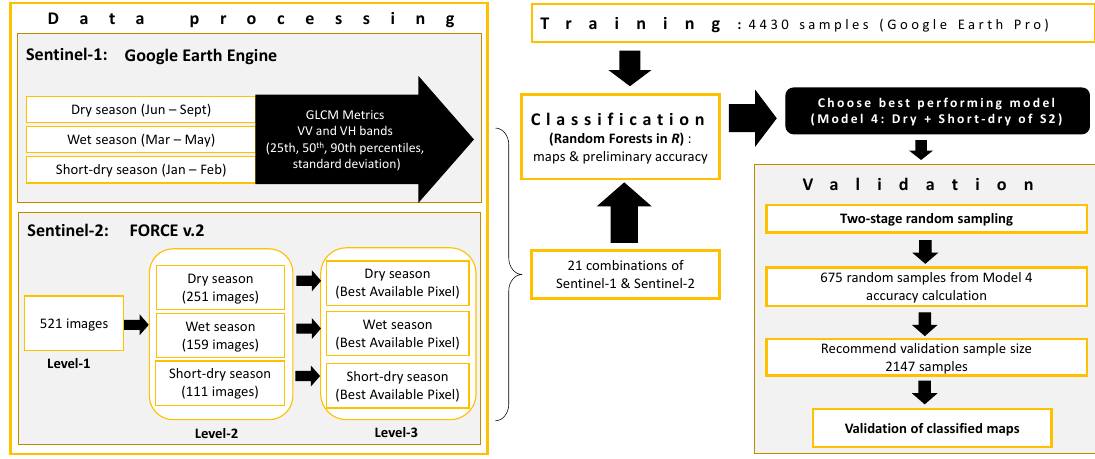
Figure 2. Methodological framework. Google Earth Engine: Gorelick et al. [50]. FORCE (i.e., Framework for Operational Radiometric Correction for Environmental monitoring): Frantz et al. [35].